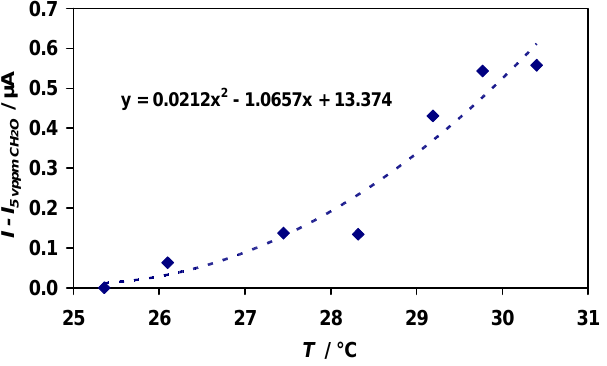
Figure 12. Influence of temperature increase on the sensor signal for 5